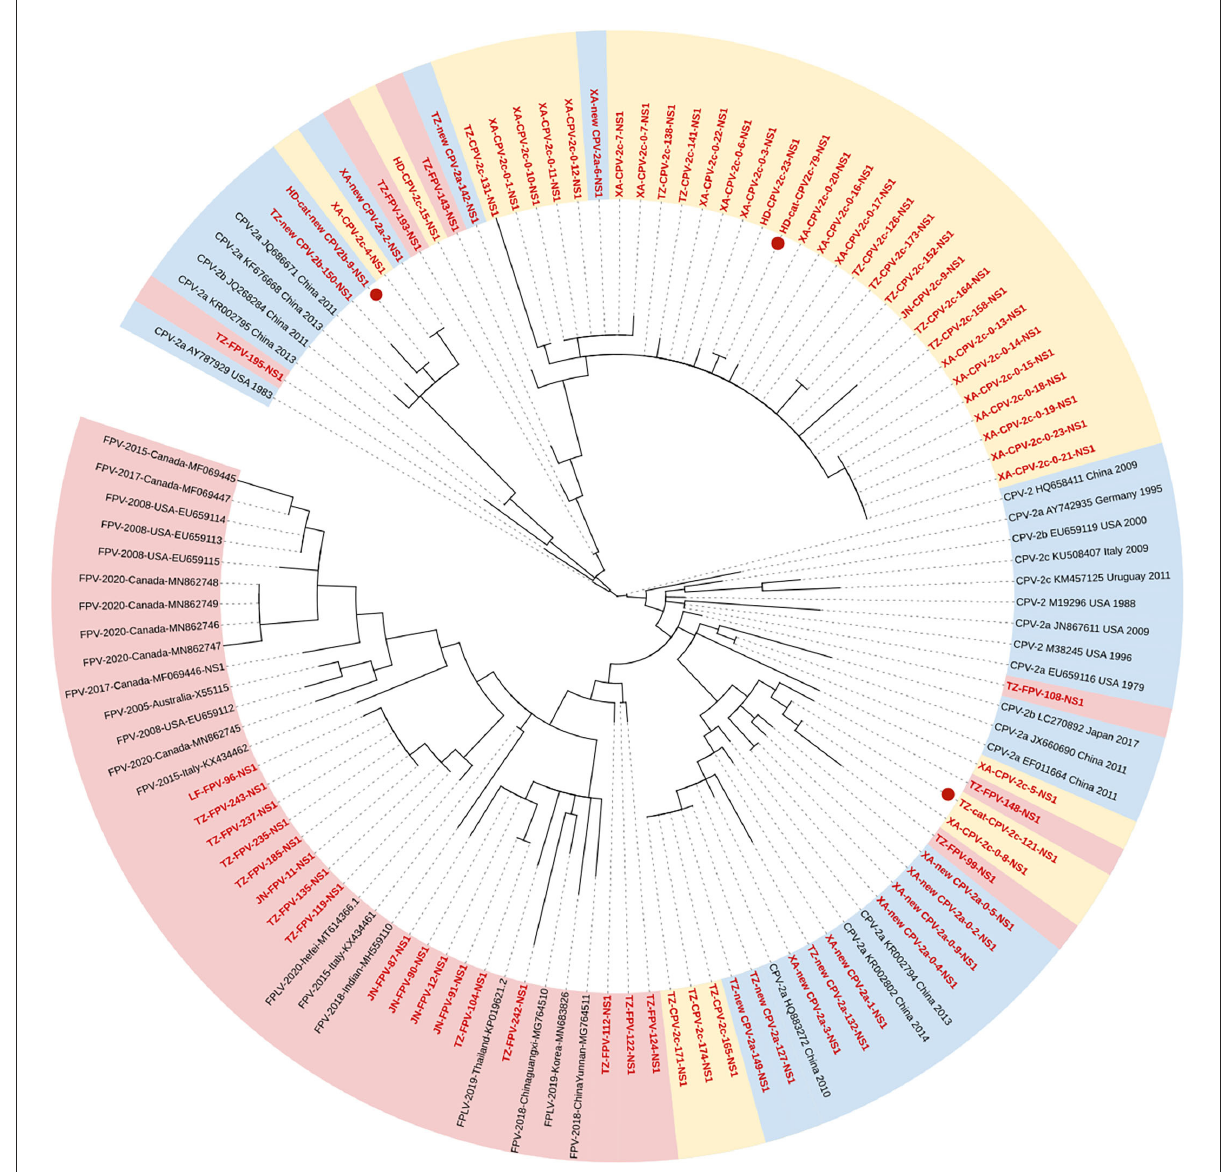
FIGURE2 Phylogenetic tree based on a comparison of the non-structural (NS1) gene of canine parvovirus type 2 (CPV-2) and feline panleukopenia virus (FPV). Phylogenetic relationships were calculated using the maximum likelihood (ML) method. Gaps were handled by pairwise deletion and bootstrap values were calculated from 1,000 replicates. Strains analyzed in this study are marked in red and reference strains are marked in black. CPV-2 strains isolated from cats in this study are marked with “ .” The monophyletic clusters of new CPV-2a/2b are marked in blue (Clade IIA), the monophyletic clusters of CPV-2c are marked in yellow (Clade IIB), and the monophyletic clusters of FPV are marked in pink (Clade